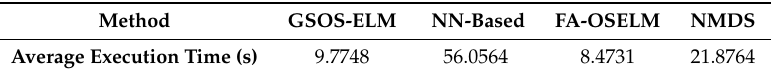
Table 8. Comparison of Average Execution Time under Realistic Environment.